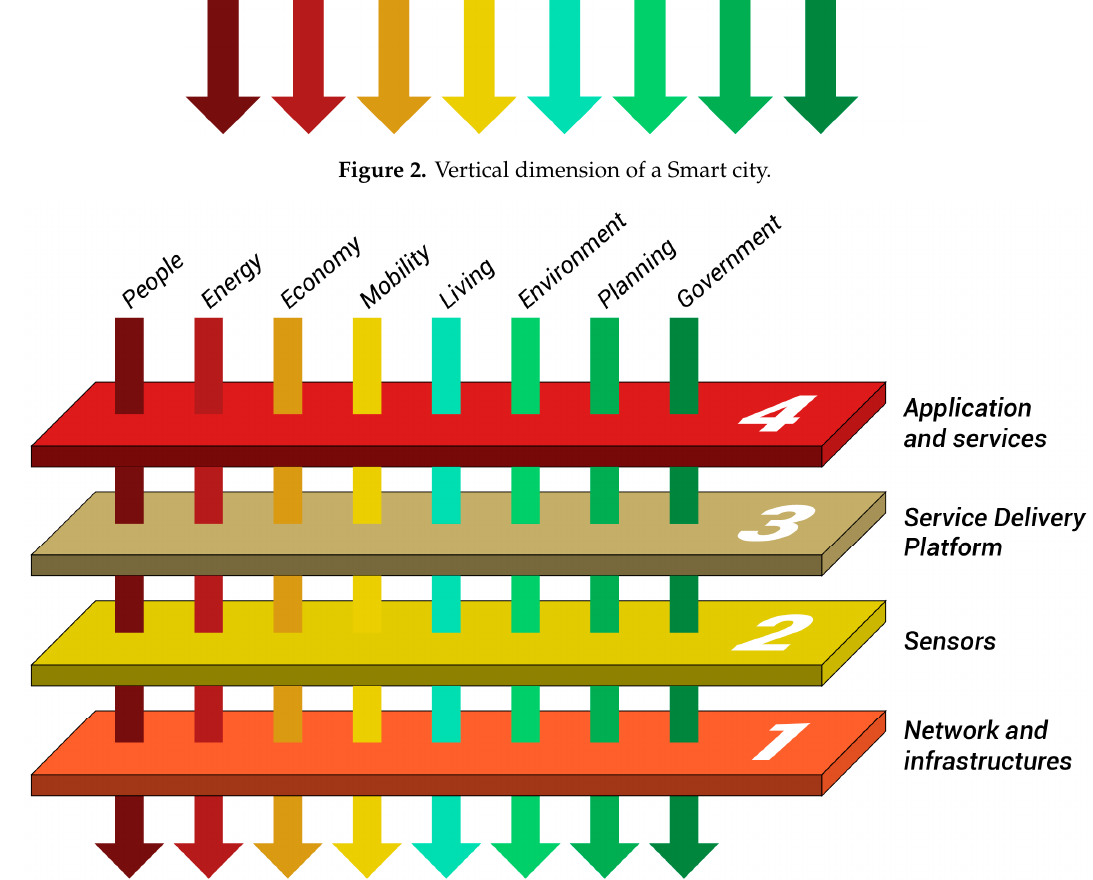
Figure 3. The interaction between application domains and technological layers.